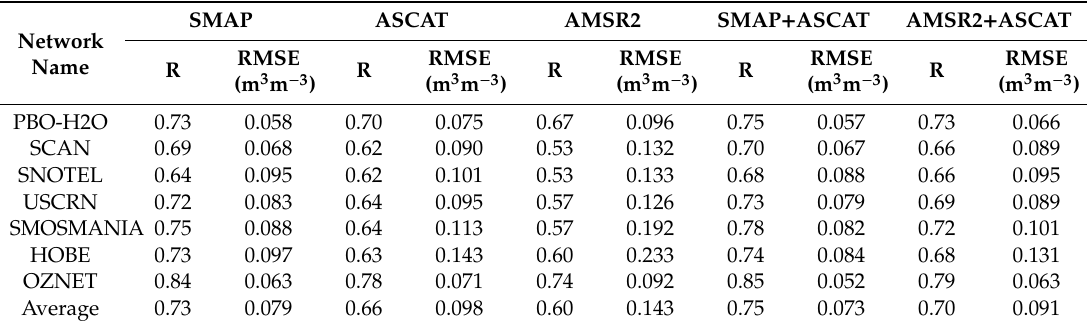
Table 3. The results of overall averages of R and RMSE for the comparison of merged (SMAP + ASCAT and AMSR2 + ASCAT) and parents (SMAP, ASCAT, and AMSR2) SM datasets with the in-situ SM observations of di ff erent ISMN networks. Note that, p -value <